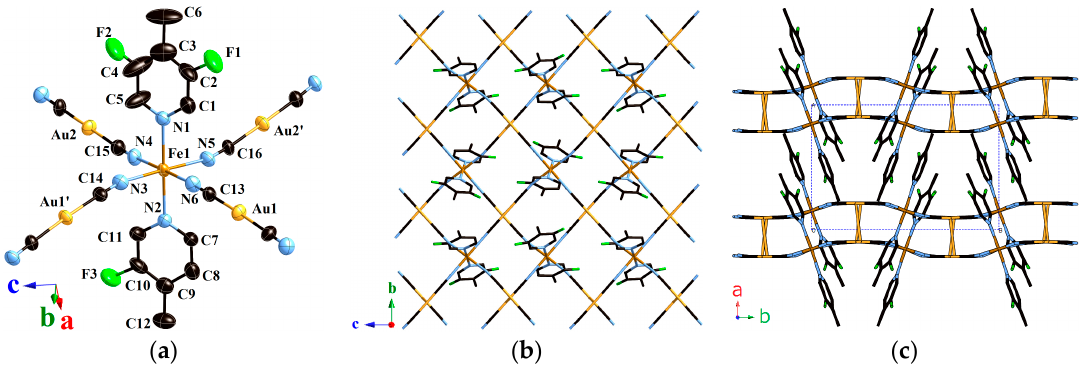
Figure 1. ( a ) Coordination structure of compound 1 containing its asymmetric unit at 293 K; ( b ) View of the 2-D layer structure of 1 ; ( c ) Stacking of four consecutive layers of 1 at 293 K. In these pictures, hydrogen atoms are omitted for clarity.